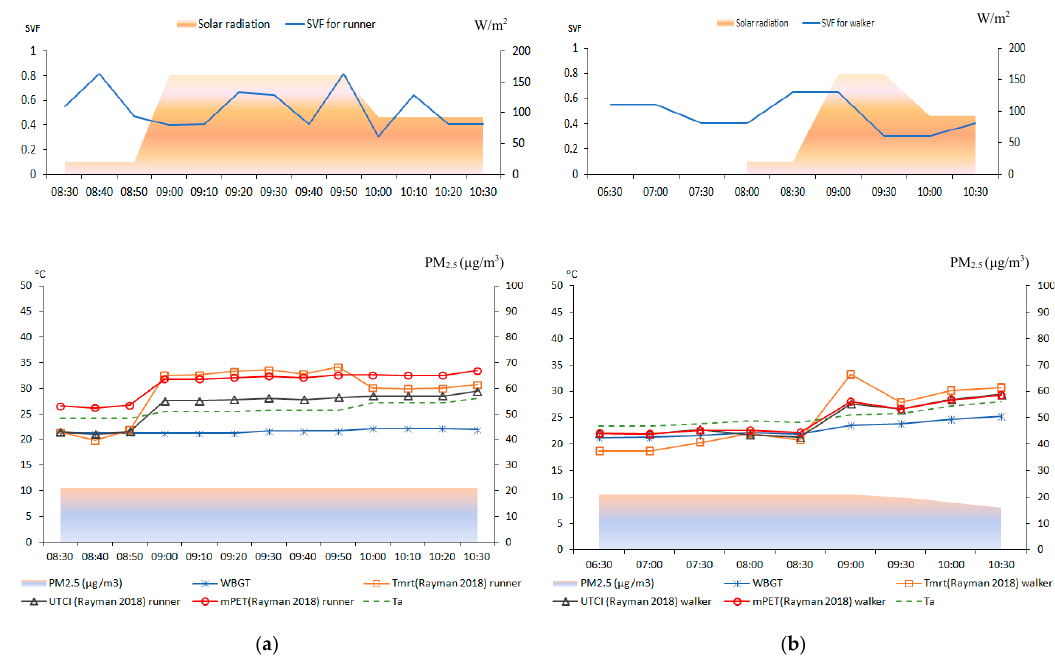
Figure 5. Spring running event thermal and environmental conditions for runners ( a ) and walkers ( b ).